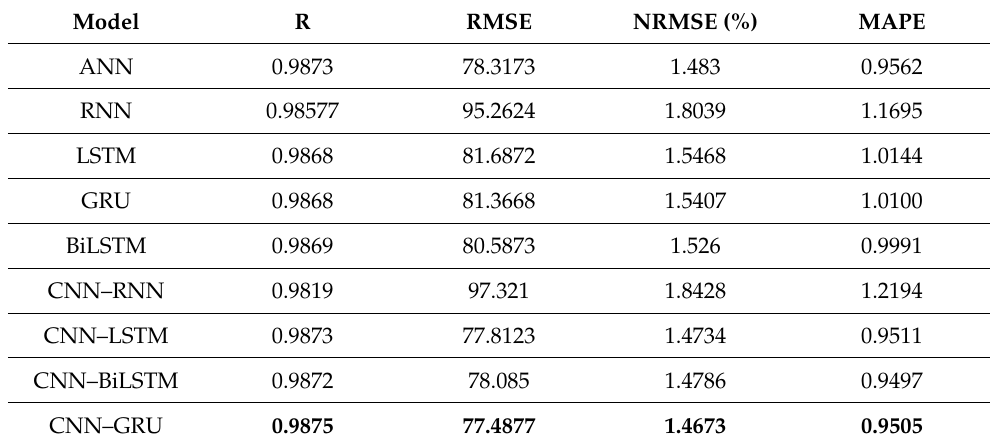
Table 2. Prediction error (R, RMSE, NRMSE, and MAPE) for the Jeddah results.